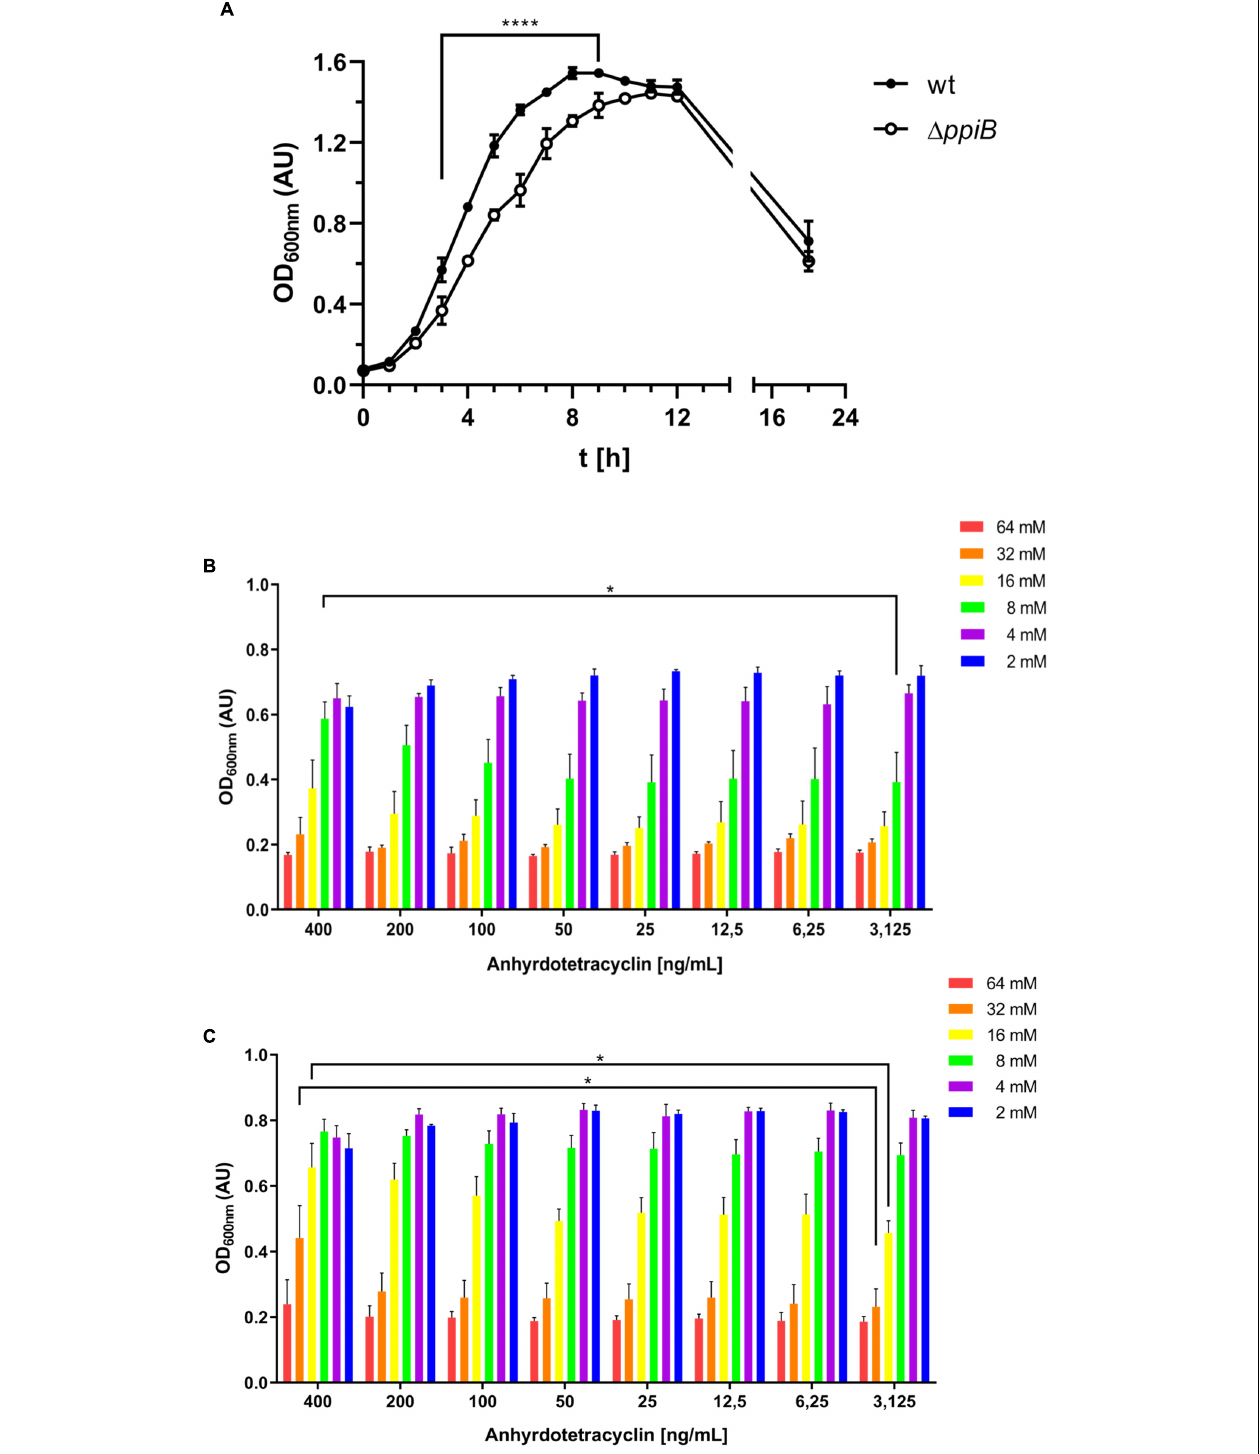
FIGURE 6 | CdPpiB confers cysteine tolerance to C. difficile . (A) Destruction of ppiB causes growth defect in BHIS as assessed by the change in the OD 600 nm over time. (B) Complementation of the (cid:49) ppiB mutant through induction with 400 ng/mL anhydrotetracycline allows the bacteria to cope with 8 mM L -cysteine when grown in BHI supplemented with different concentrations of cysteine. (C) Stepwise over-expression of ppiB with increasing amounts of anhydrotetracycline raises the tolerance of the wild type toward 16 and 32 mM L -cysteine. Shown are means ± SEM of three independent experiments performed in duplicate. Statistical significance was calculated by unpaired t- Test ( ∗ p ≤ 0.05, ∗∗∗∗ p ≤ 0.0001).